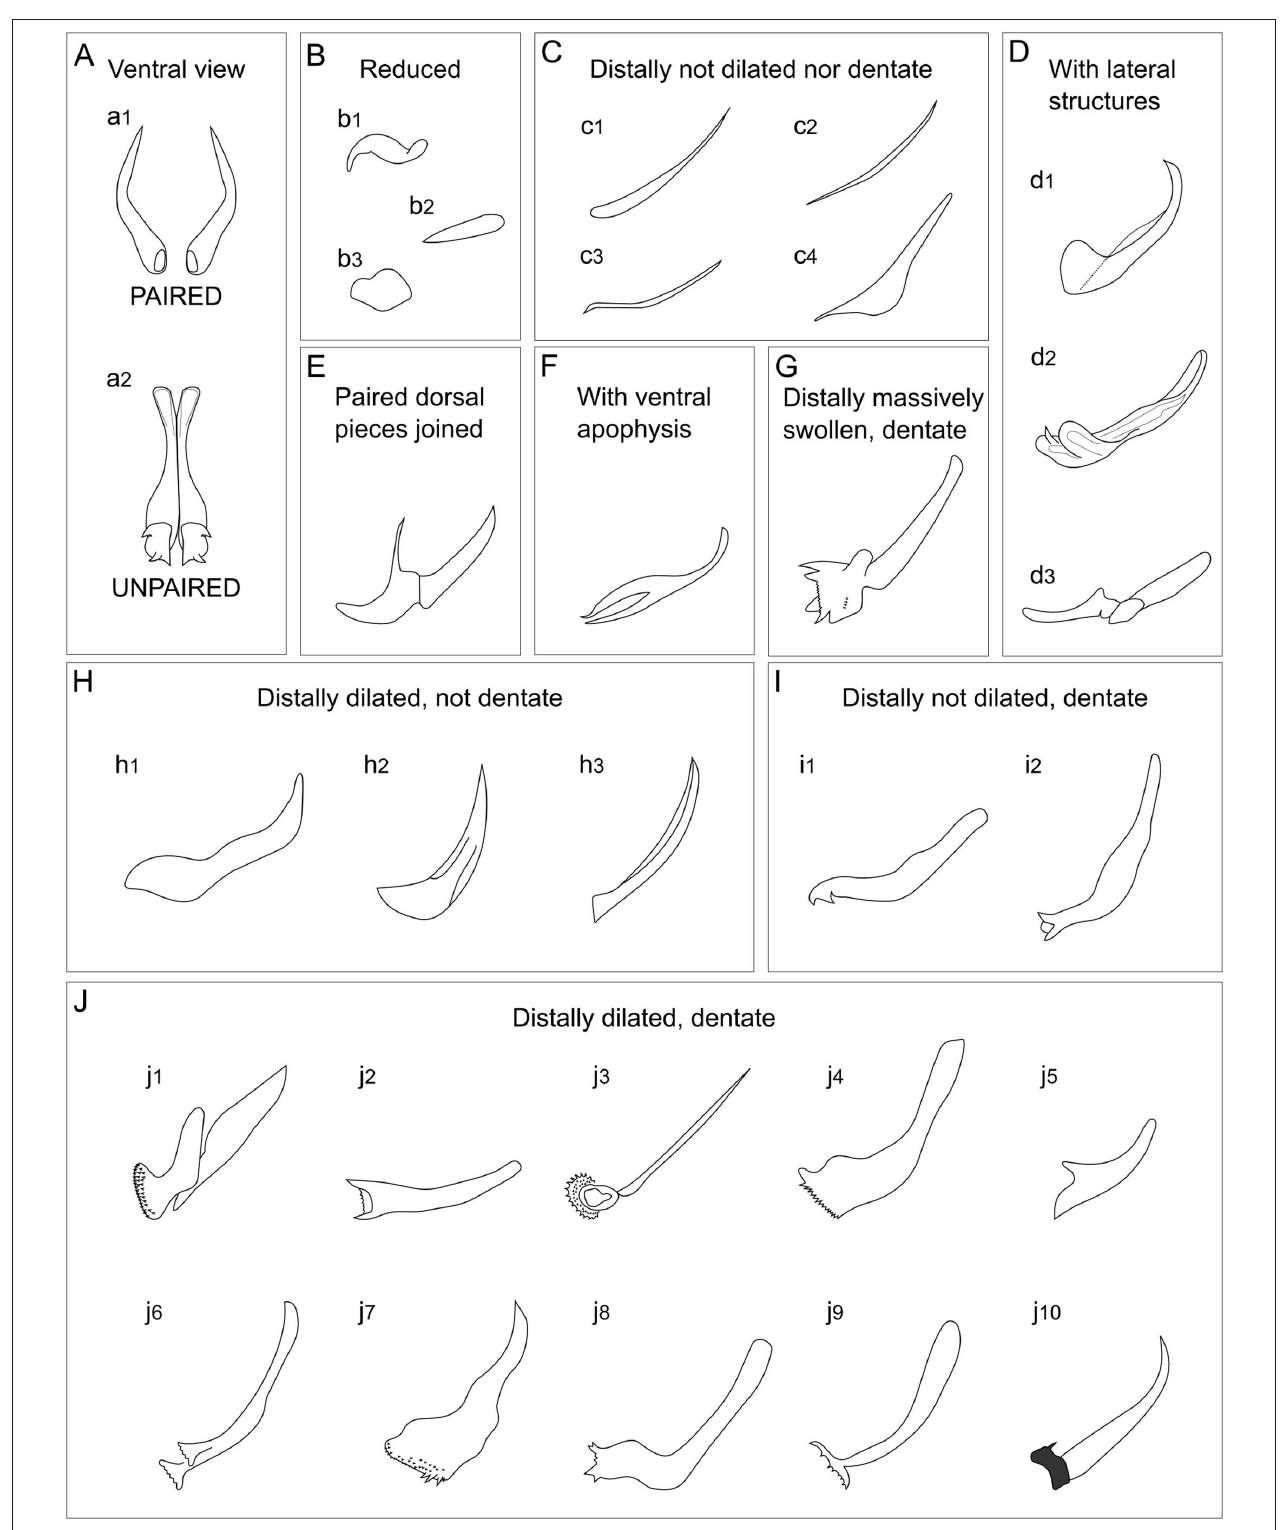
FIGURE 4 | Examples of the different gubernaculum types of Cyatholaimidae species. (A) Ventral view showing a gubernaculum (a1) paired and an (a2) unpaired. (B–J) Lateral view. (B) Reduced, (b1) Paracyatholaimoides asymmetricus , (b2) Craspodema octogoniata , (b3) Xenocyatholaimus delamarei ; (C) Distally not dilated nor dentate, (c1) Biarmifer laminatus , (c2) Paracyatholaimoides mutispiralis , (c3) Paracyatholaimus diva , (c4) Paralongicyatholaimus minutus ; (D) With lateral structures,